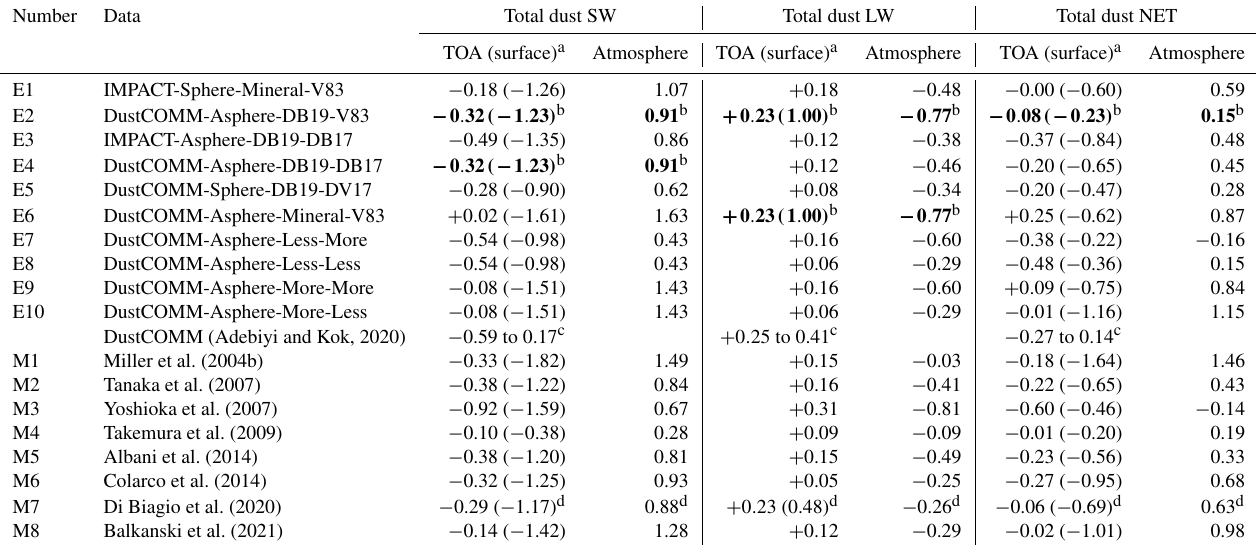
a The parentheses represent the RE at the surface. b The bold represents the combination of DB19 for SW and V83 for LW (i.e., DustCOMM-Asphere-DB19-V83). c The 98% confidence interval of the DustCOMM data set is listed. d For a comparison with our estimates, the sum of single mode simulations from Di Biagio et al. (2019) is